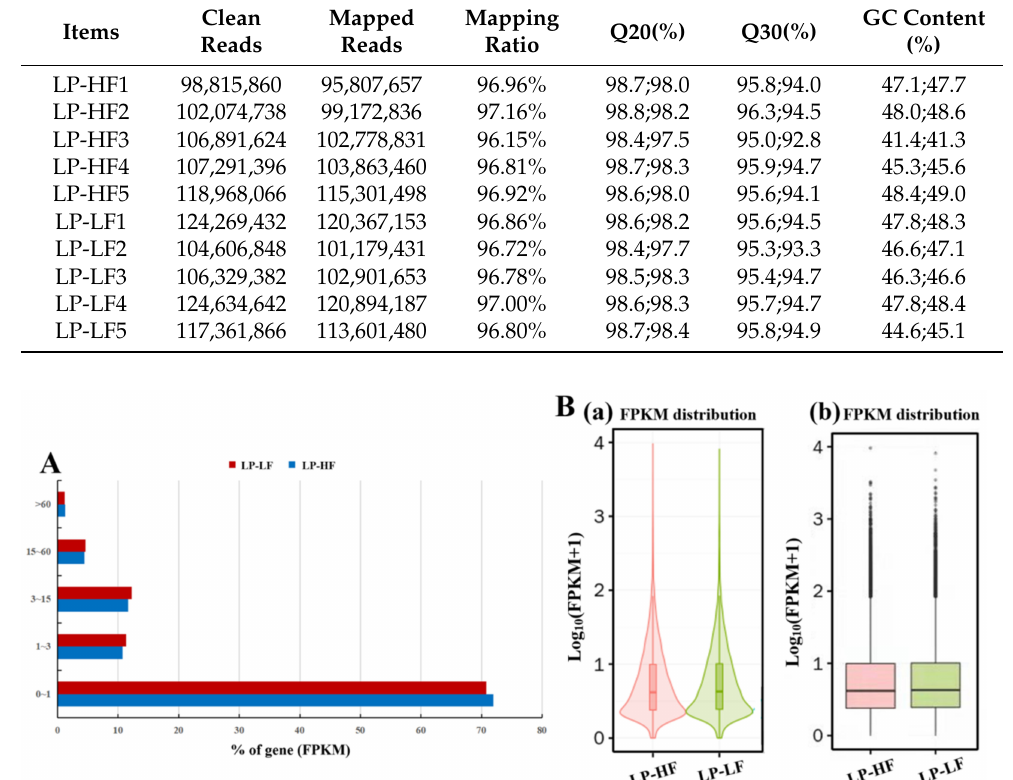
Table 2. Statistics for the cDNA library sequences of the hypothalamic tissue in the luteal phase.